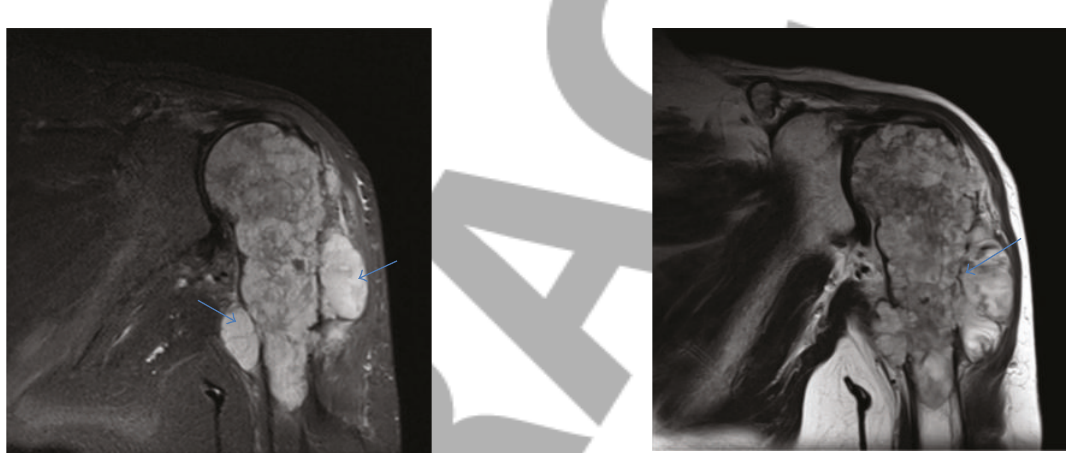
Figure 6: 60-year-old female with swelling in upper arm. MRI was done on 1.5 T Siemen’s machine. Coronal T2WI showing hyperin- tense lobulated mass with fibrous septae (arrow).